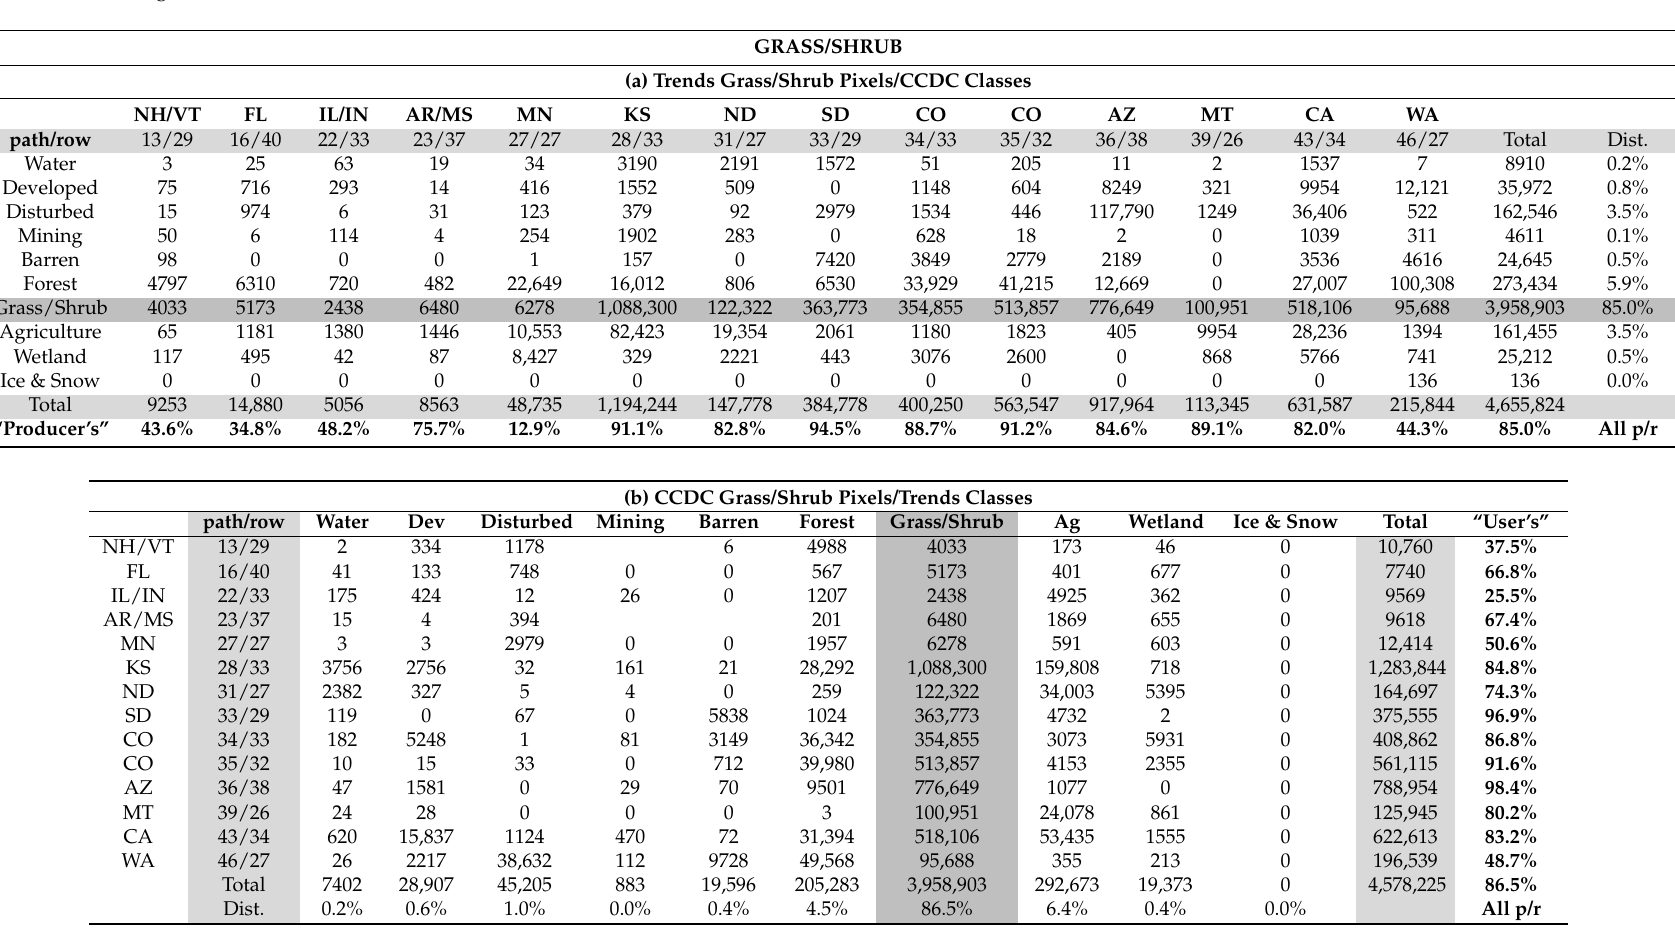
Table 7. (a) LC Trends circa 2000 Grass/Shrub pixels distributed across CCDC classes for each path/row location and (b) CCDC circa 2000 Grass/Shrub pixels distributed across LC Trends classes for each path/row location. AR = Arkansas; AZ = Arizona; CA = California; CO = Colorado; FL = Florida; IL = Illinois; IN = Indiana; KS = Kansas; MN = Minnesota; MS = Mississippi; MO = Montana; ND = North Dakota; NH = New Hampshire; SD = South Dakota; VT = Vermont; WA =